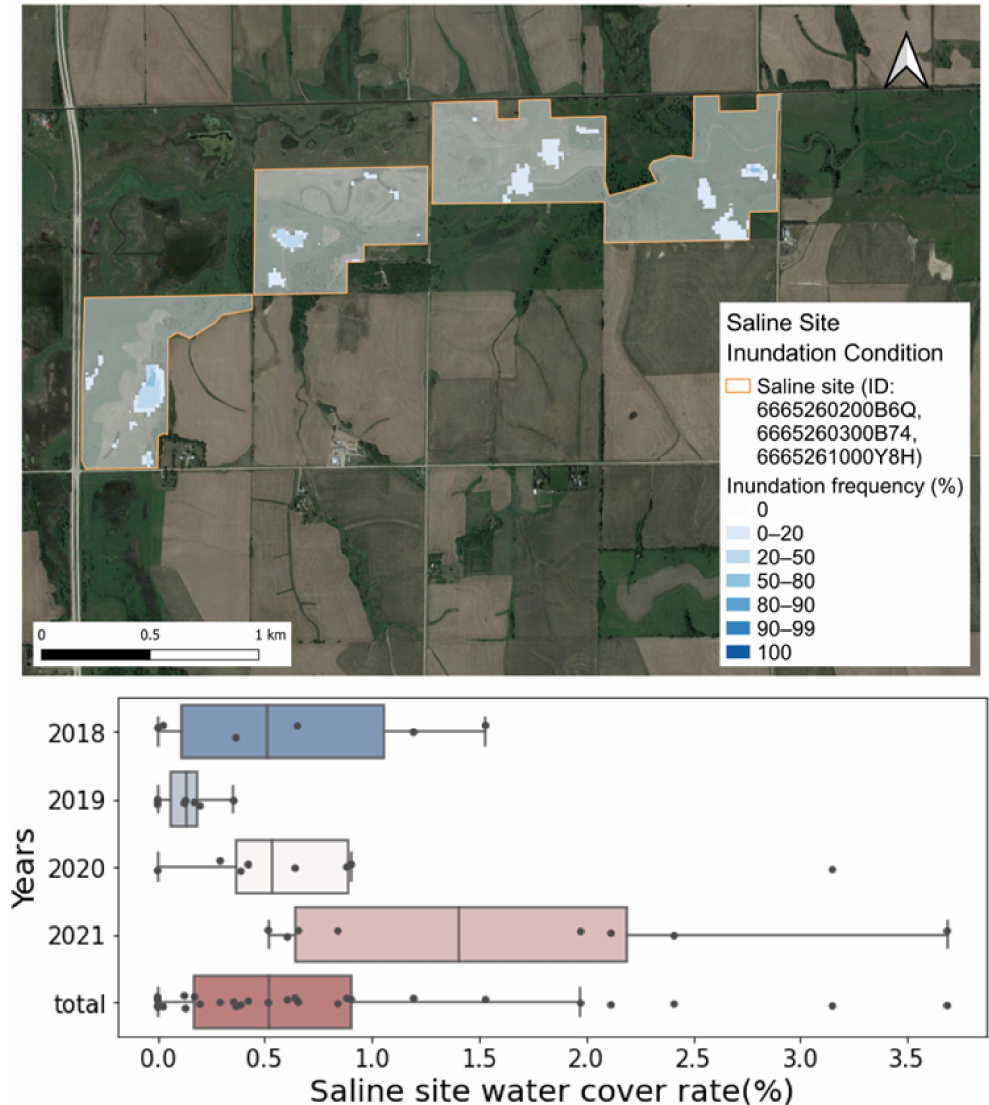
Figure 10. Inundation frequency and surface water cover rate in the saline